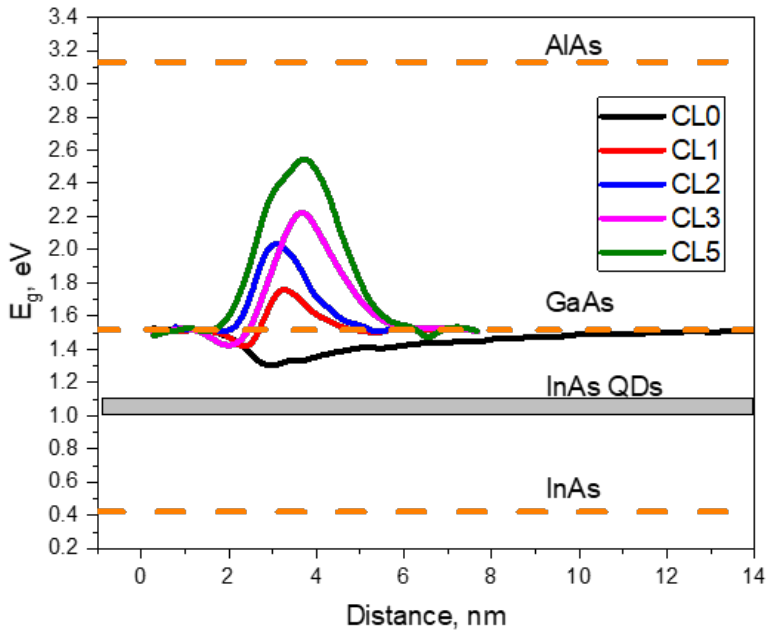
Figure 9. Bandgap approximation at 4.2 K of the WL/CL system along the growth direction, for the different layers in the regions between QDs.